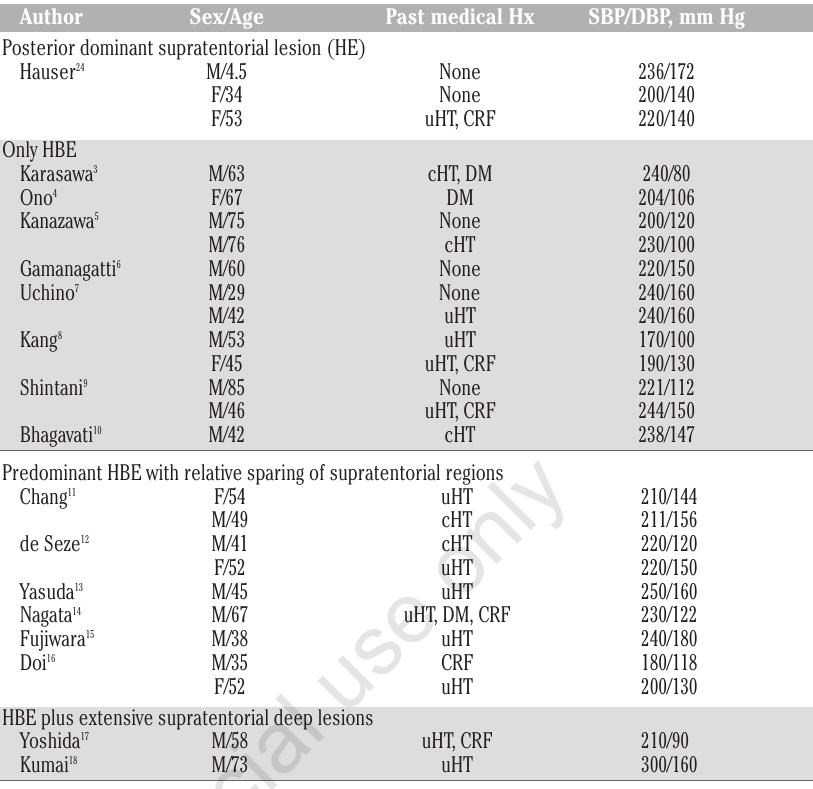
Table 1. Clinical features of patients with hypertensive encephalopathy and those with variable patterns of hypertensive brainstem encephalopathy who underwent brain com- puterized tomography scanning, magnetic resonance imaging, or